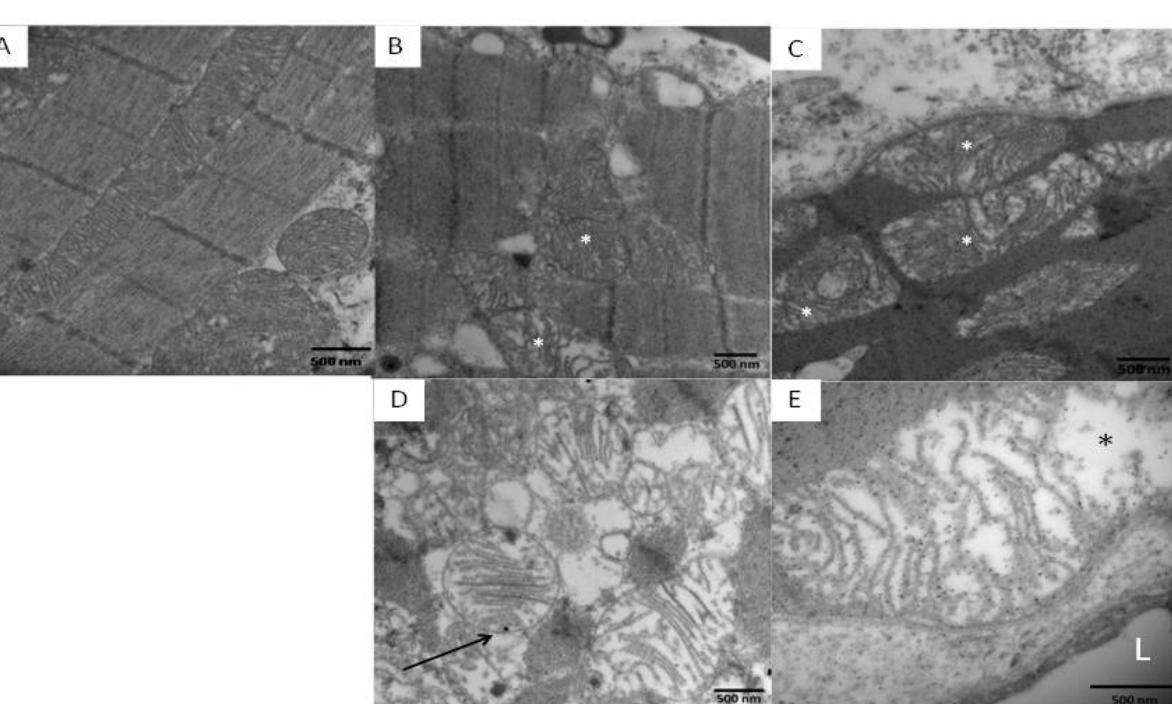
Figure 3. Mitochondrial images in left and right ventricles of control and South MCMA young dogs. ( A ) Unremarkable mitochondria and myocardial fibers in a 5 year old control left ventricle, magnification ×14,500; ( B ) Abnormal mitochondria had fragmented or missing cristae, magnification ×36,400; ( C ) Intra-mitochondrial lucent areas (white in B , C , and black in E *) are common in subsarcolemmal location, magnification ×43,700; ( D ) Abnormal mitochondria with intracristae nanosized PM (arrow), magnification ×43,700; and (E) Nanosized particles are seen in both abnormal cristae and in the midst of the electron lucent matrix, magnification ×72,900. Scale bar = 500